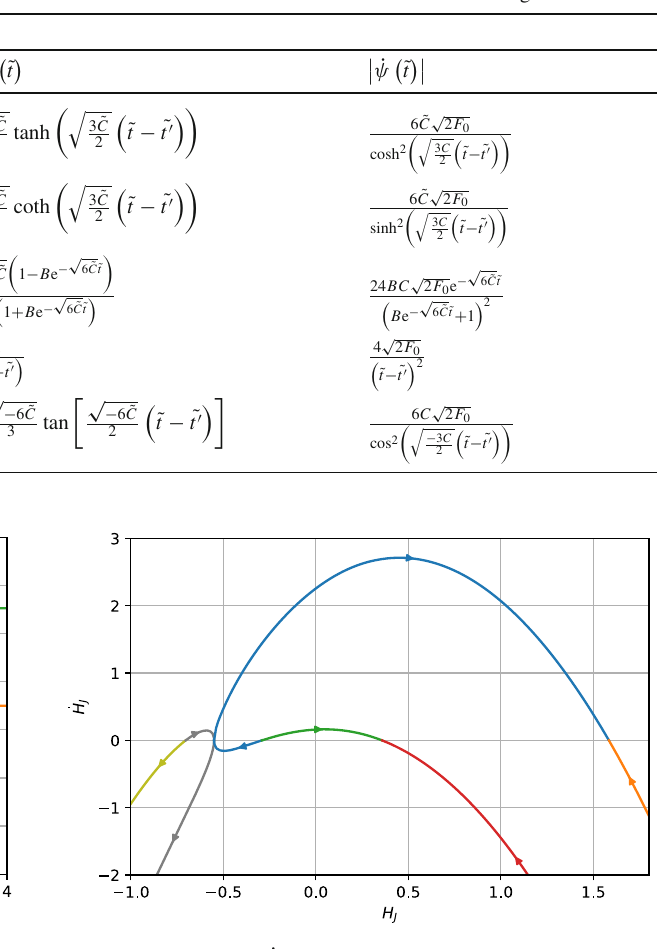
Fig. 3 Phase portraits ˙ H J ( H J ) for C 1 = 1 . 1, C 2 = ± 1. Parts of the curves corresponding to the different possible solutions are in different colors. The blue and gray trajectories are described by two equations – Eqs. (61) and (65). The change of the equation describing these trajec- tories occurs at H J = − C 1 / 2 = − 0 .